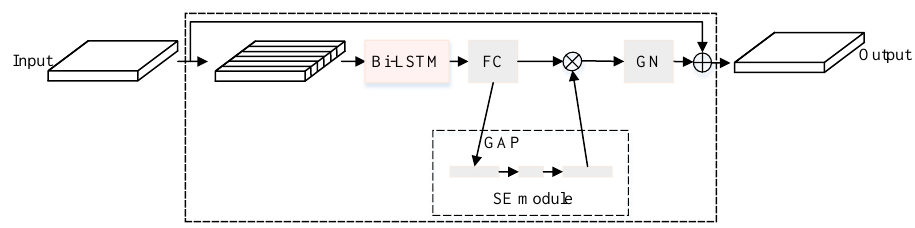
Figure 3. Structure of the LSTM